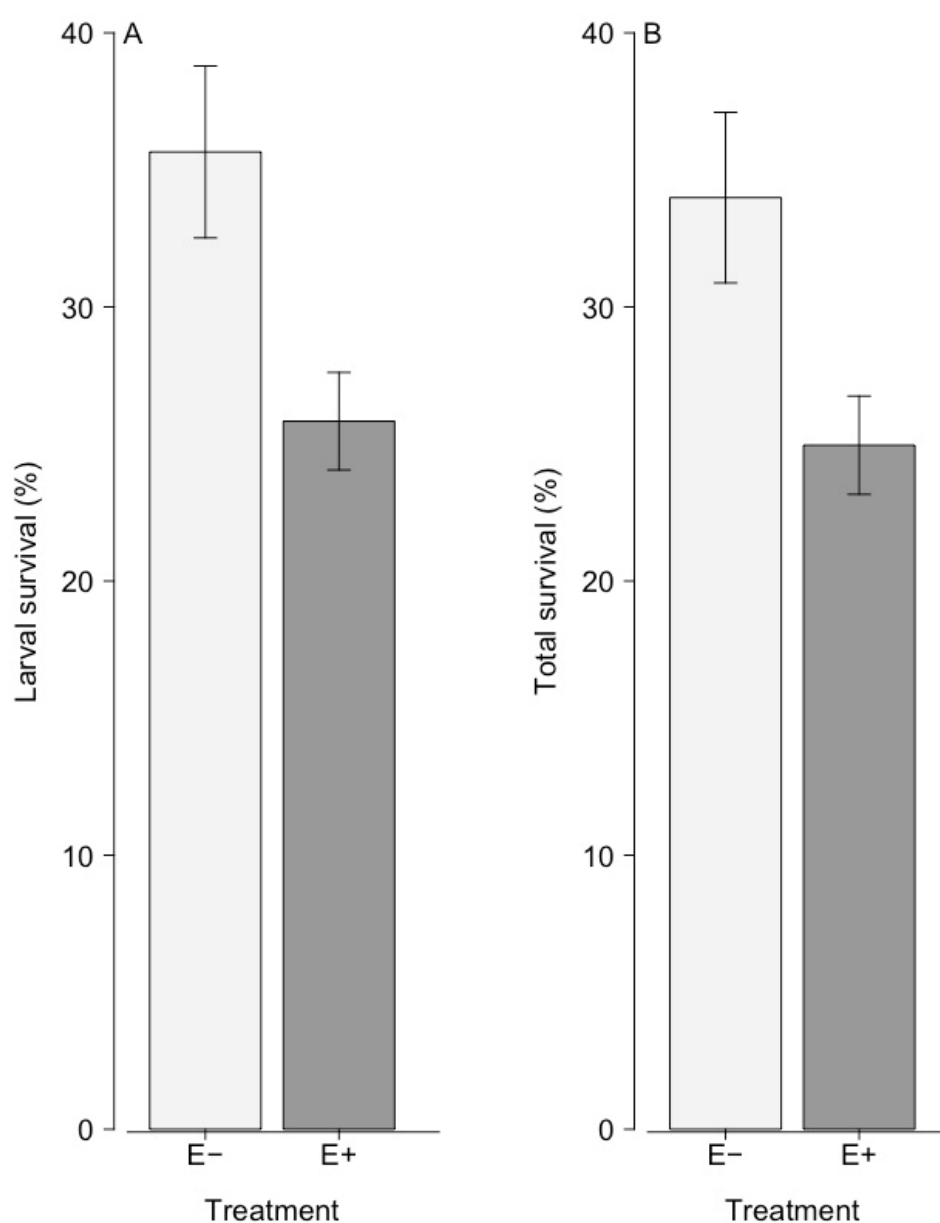
Figure 1. Mean ( ± SE) larval (i.e., second instar to pupa) ( A ) and total (i.e., second instar to adult emergence) ( B ) survival of eastern spruce budworms reared on white spruce trees. Thirty-two trees contained a native endophytic fungus (E + , dark bars) and 32 control trees did not (E − , light bars).